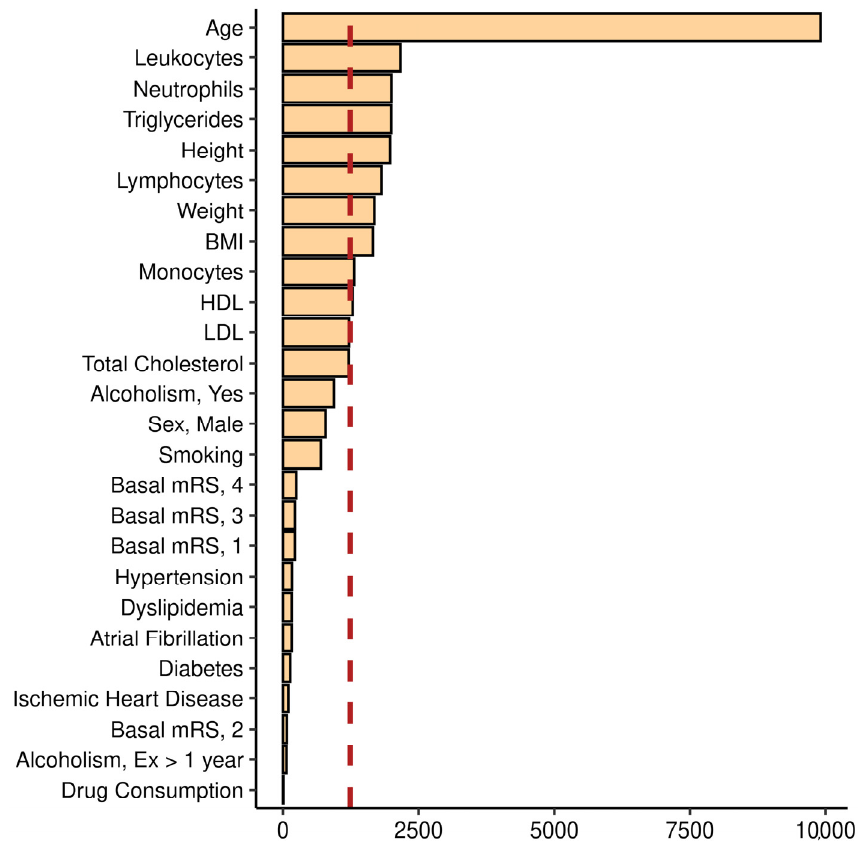
Figure 1. Importance plot obtained from Random Forest model training. The y axis shows one tick per variable, while the x axis shows the mean decrease in Gini index (purity of splits). The red dashed line shows the average importance of the variables selected for the training. Keywords: BMI, body mass index; HDL, high-density lipoprotein; LDL, low-density lipoprotein; mRS, modified Rankin scale; Ex, ex-alcohol consumption.